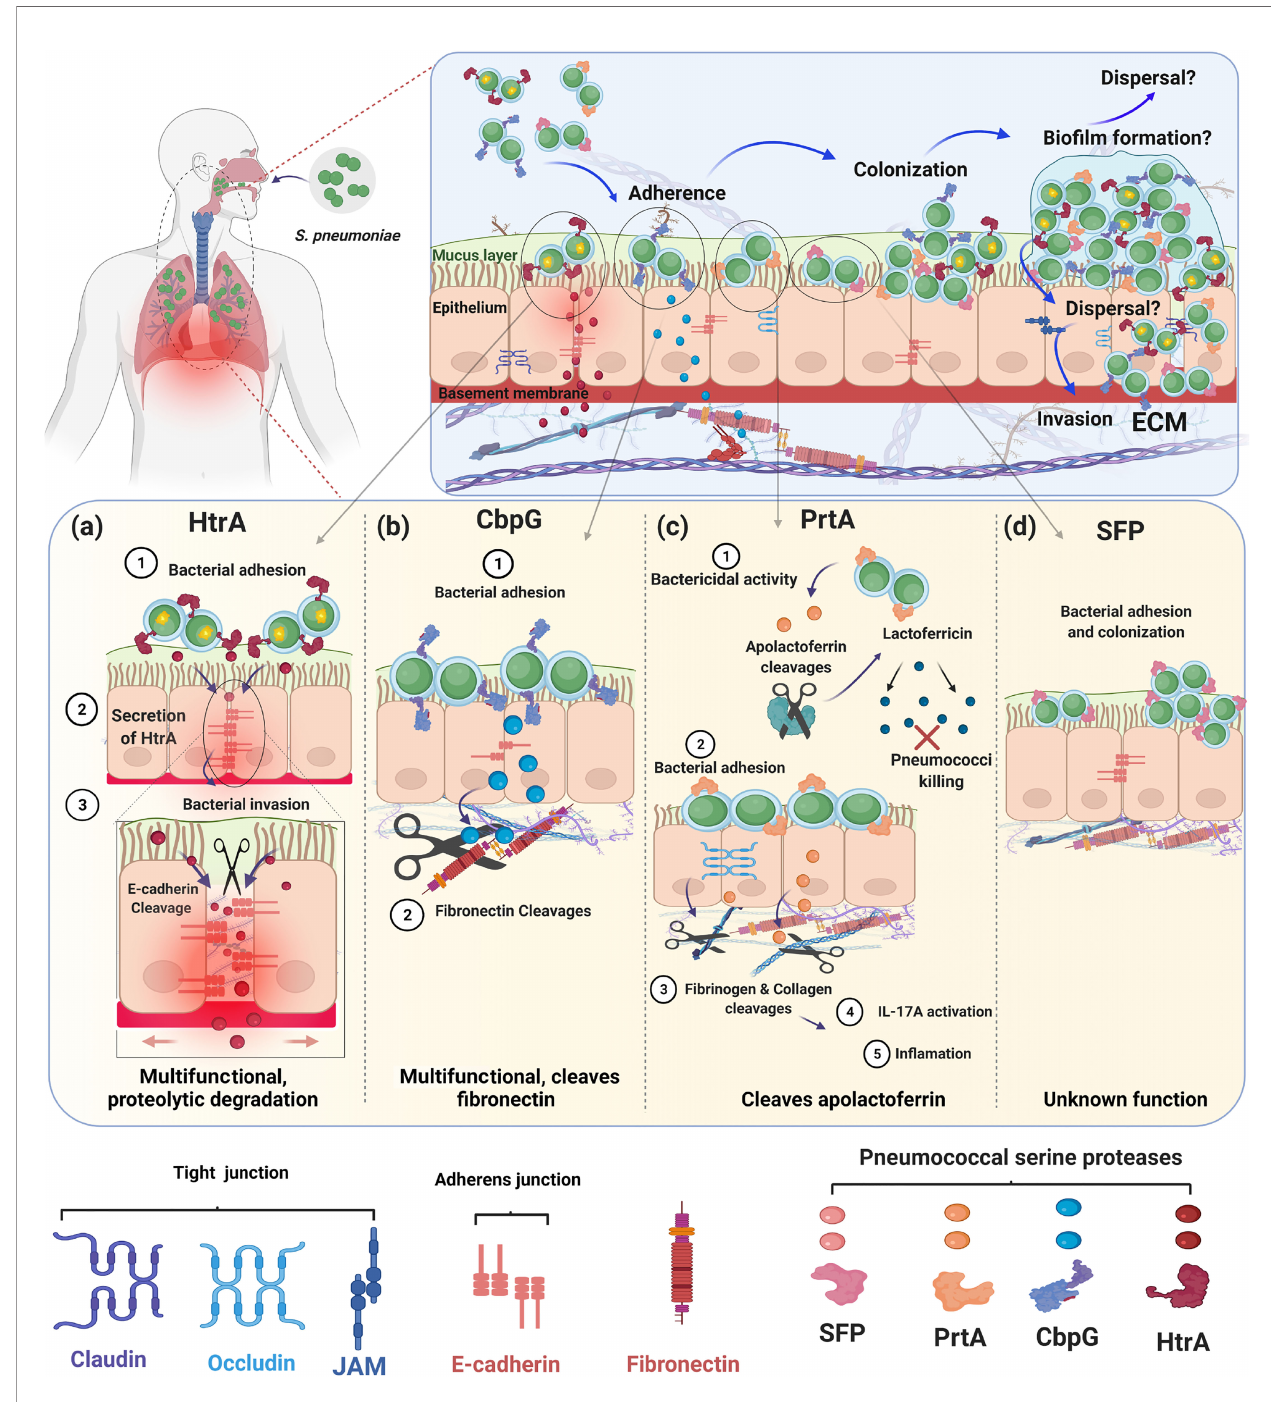
FIGURE 4 | Role of pneumococcal serine proteases during adherence, colonization and invasion of the human host. The schematic models present different strategies of pneumococcal pathogenesis and the role of extracellular pneumococcal serine proteases. The upper panel shows that all four serine proteases HtrA, CbpG, PrtA, and SFP are involved in attachment to epithelial cells during nasopharyngeal colonization. Bacterial colonization and persistence in different host niches are dependent on the pneumococcal adherence capacity to host cells and tissues. Attachment to host cells facilitates bacterial cell aggregation and the formation of sessile communities like bio fi lms. Through the increased temperature during fever, released bacteria can switch from asymptomatic colonization to severe infections. The lower panels (A) HtrA, (B) CbpG, (C) PrtA, and (D) SFP show the individual role of each serine proteases for pneumococcal adherence and their potential to digest human ECM components. Figure created with Biorender.com.